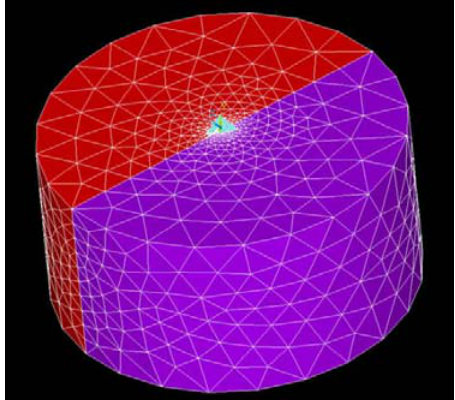
Fig. 4. Solid meshing of the composite and the indent to simulate nanoindentation at the interface of a starch/zein composite.